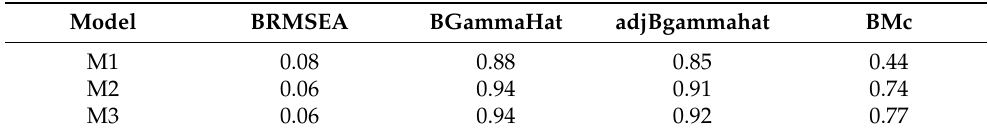
Table 4. Bayesian Confirmatory Factor Analysis fit indexes.